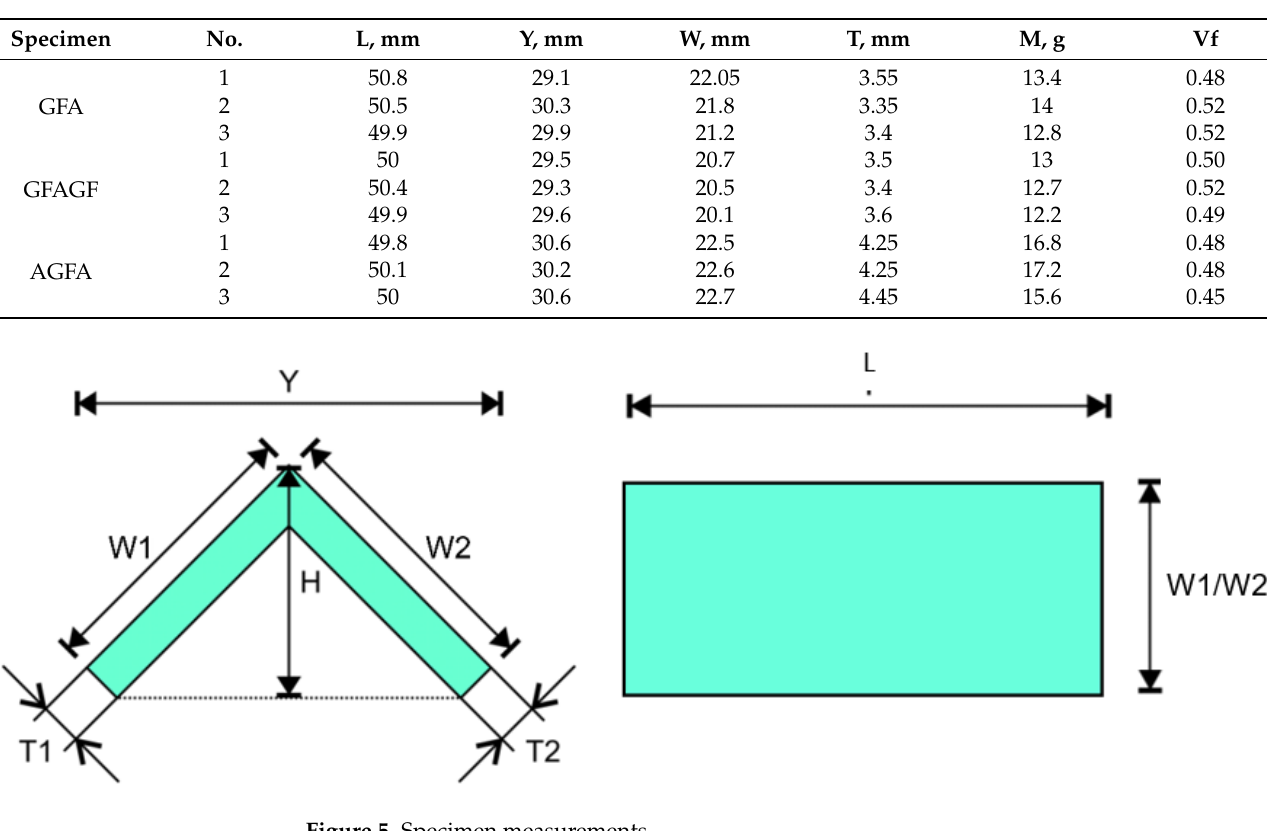
Figure 5. Specimen measurements. Table 1. Axial compression specimen dimensions and volume fraction.